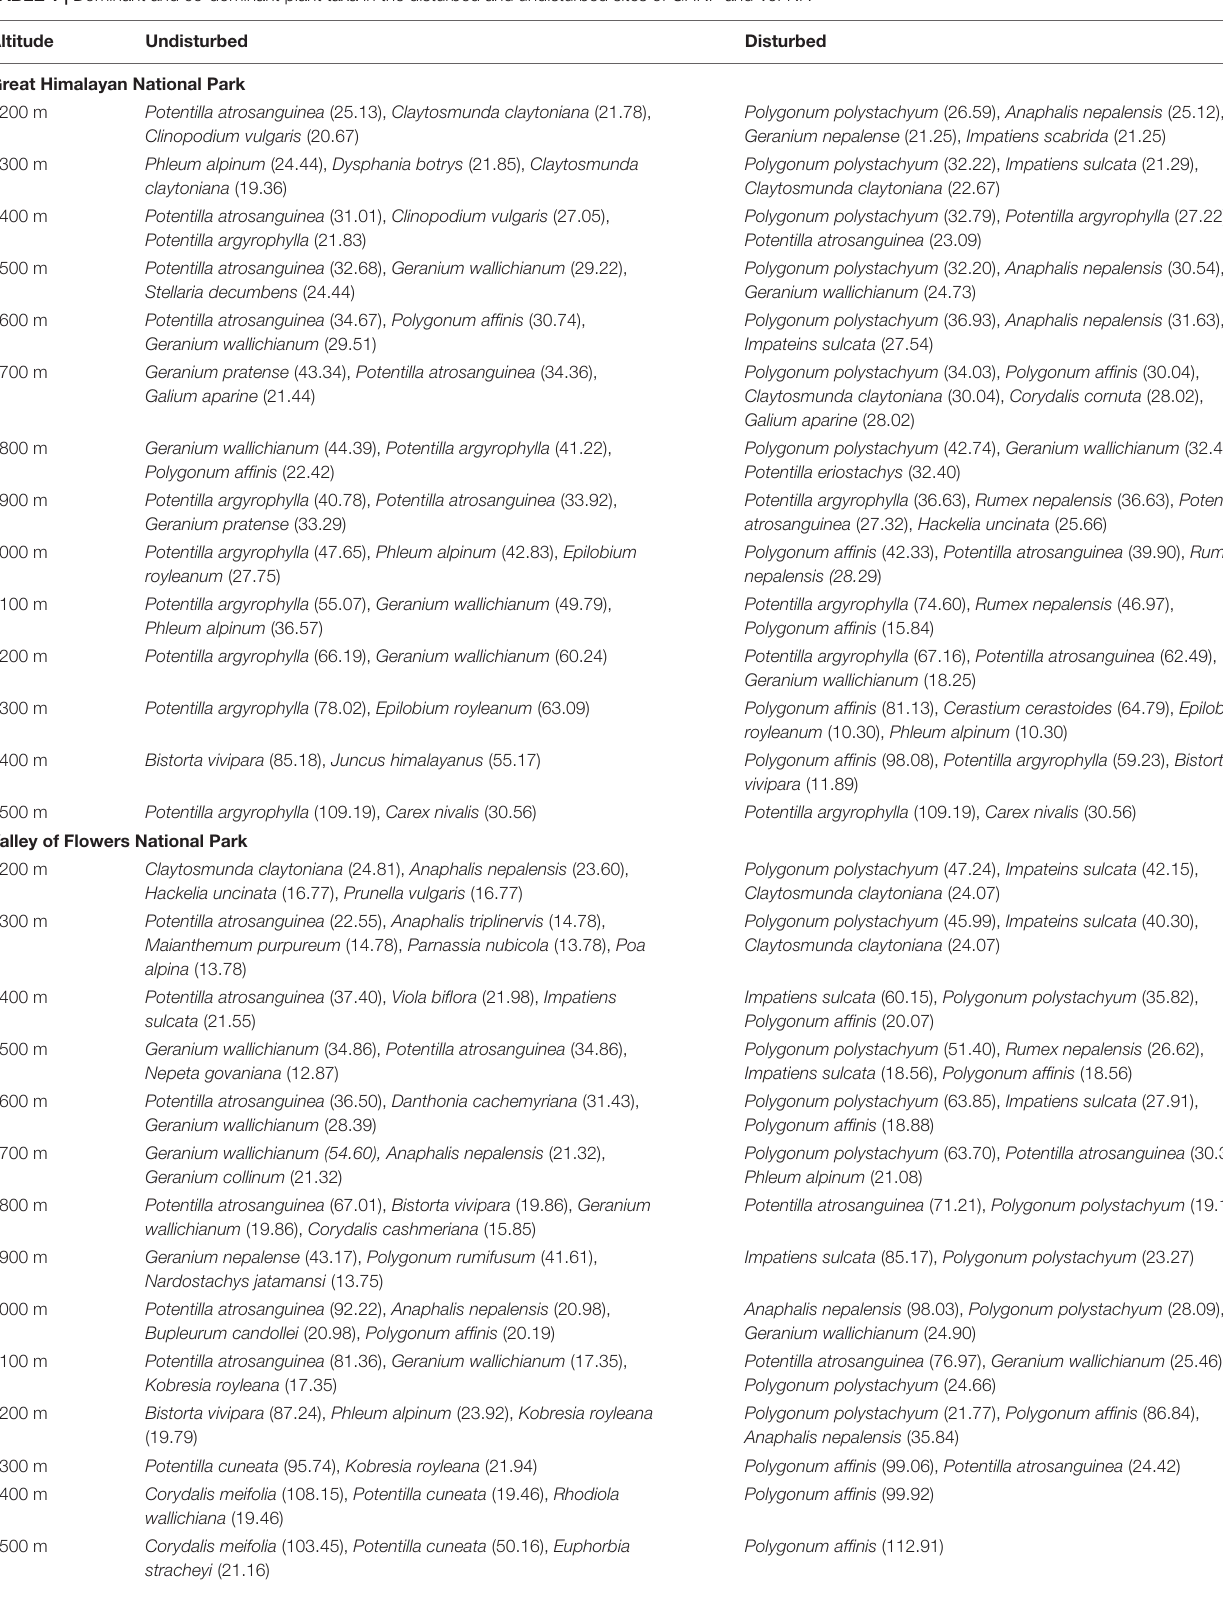
TABLE 1 | Dominant and co-dominant plant taxa in the disturbed and undisturbed sites of GHNP and VoFNP. Altitude Undisturbed Disturbed Great Himalayan National